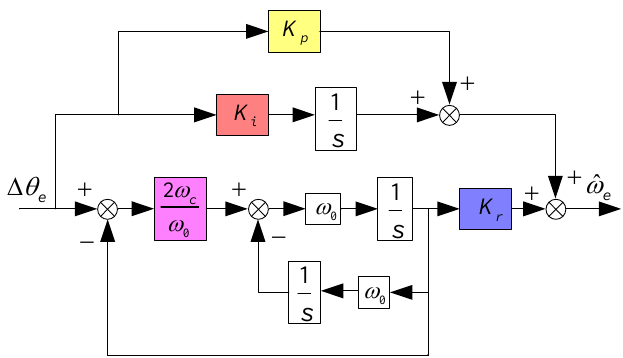
Figure 8. Block diagram of the proportional-integrational-resonant (PIR) controller.